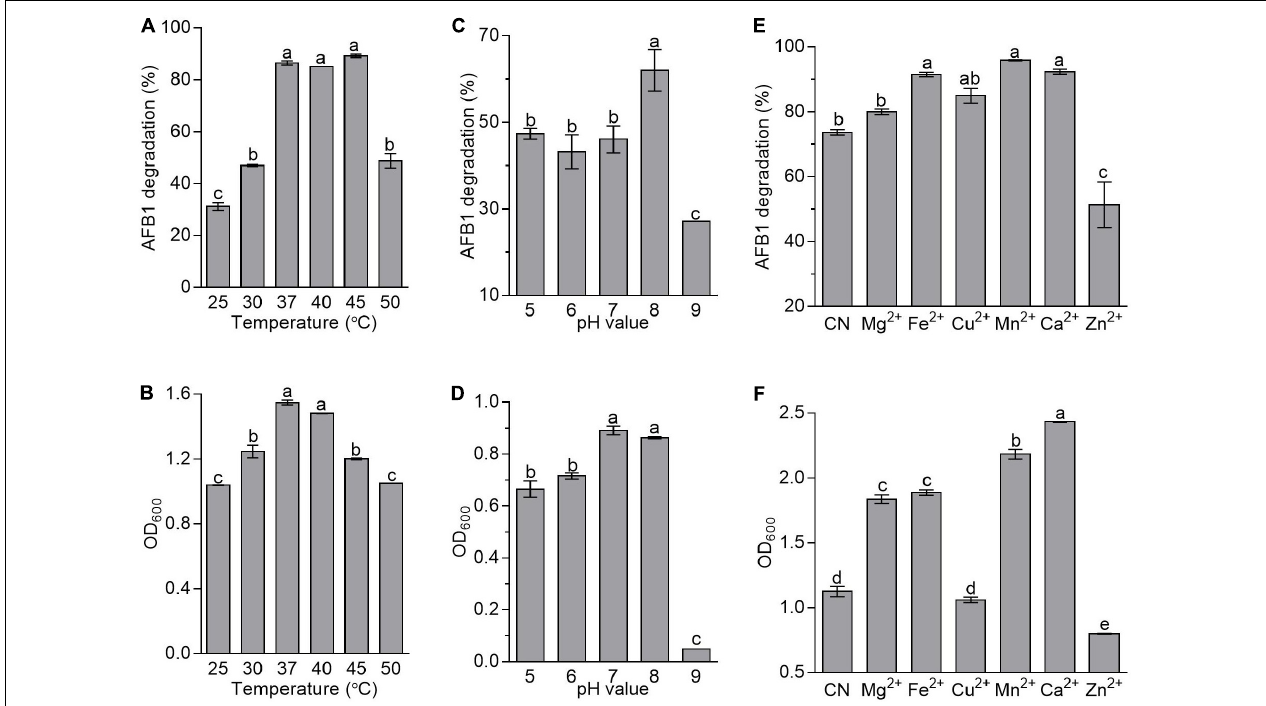
FIGURE 4 | Effects of temperature (A,B) , initial pH value (C,D) , and metal ions (E,F) on the AFB1 degradation (A,C,E) and bacterial growth (B,D,F) in B. amyloliquefaciens WF2020. In terms of temperature, the residual AFB1 was analyzed after B. amyloliquefaciens WF2020 was co-incubated with 2 µ g/ml AFB1 for 72 h. With respect to the effects of initial pH value and metal ions, the residual AFB1 was analyzed after B. amyloliquefaciens WF2020 was co-incubated with 2 µ g/ml AFB1 at 37 ◦ C for 24 and 48 h, respectively. Different lowercase letters on the bars of each group indicate significant differences between the treatments (Tukey’s test, p <